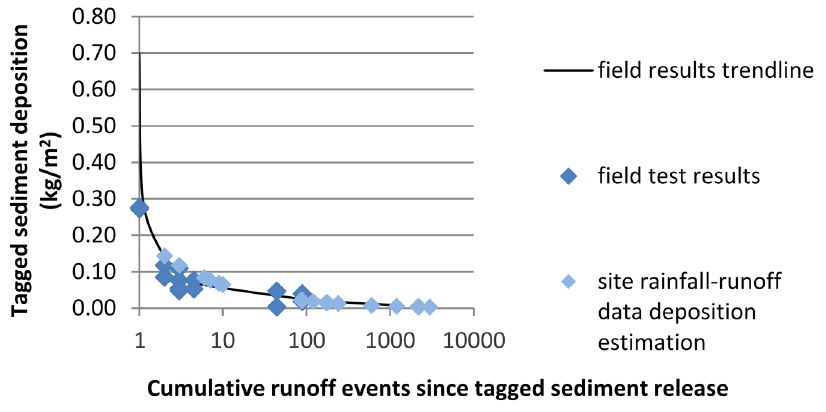
Figure 5. Field monitored and empirically estimated trace sediment deposition within the swale over multiple runoff